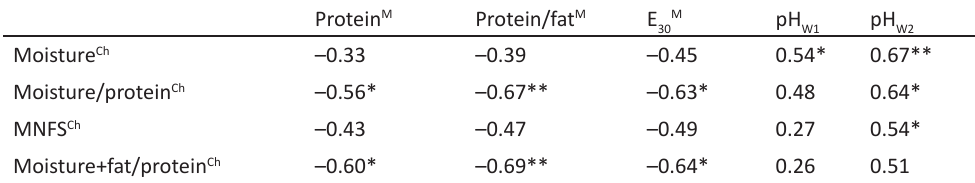
Table 5. Spearman correlation coefficients between milk and cheese parameters Protein M